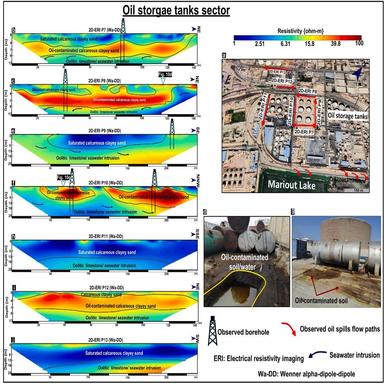
(a) 2D-ERI P7-P13 at oil storage tanks sector showing the oil spill towards Mariout Lake. Note, 2D-ERI P–P5 is overlapped 2D-ERI P4 and P5 profiles. (b, c, e, f, h, i and j) 2D electrical resistivity models of 2D-ERI P7, P8, P9, P10 and P11, respectively, obtained from 2D inversion of jointed Wa and DD (Wa-DD) datasets applying AIA using a blocky model option (L1-norm inversion) and calibrated with the observed borehole information. (d and g) field photos showing oilcontaminated water and soil at oil stora